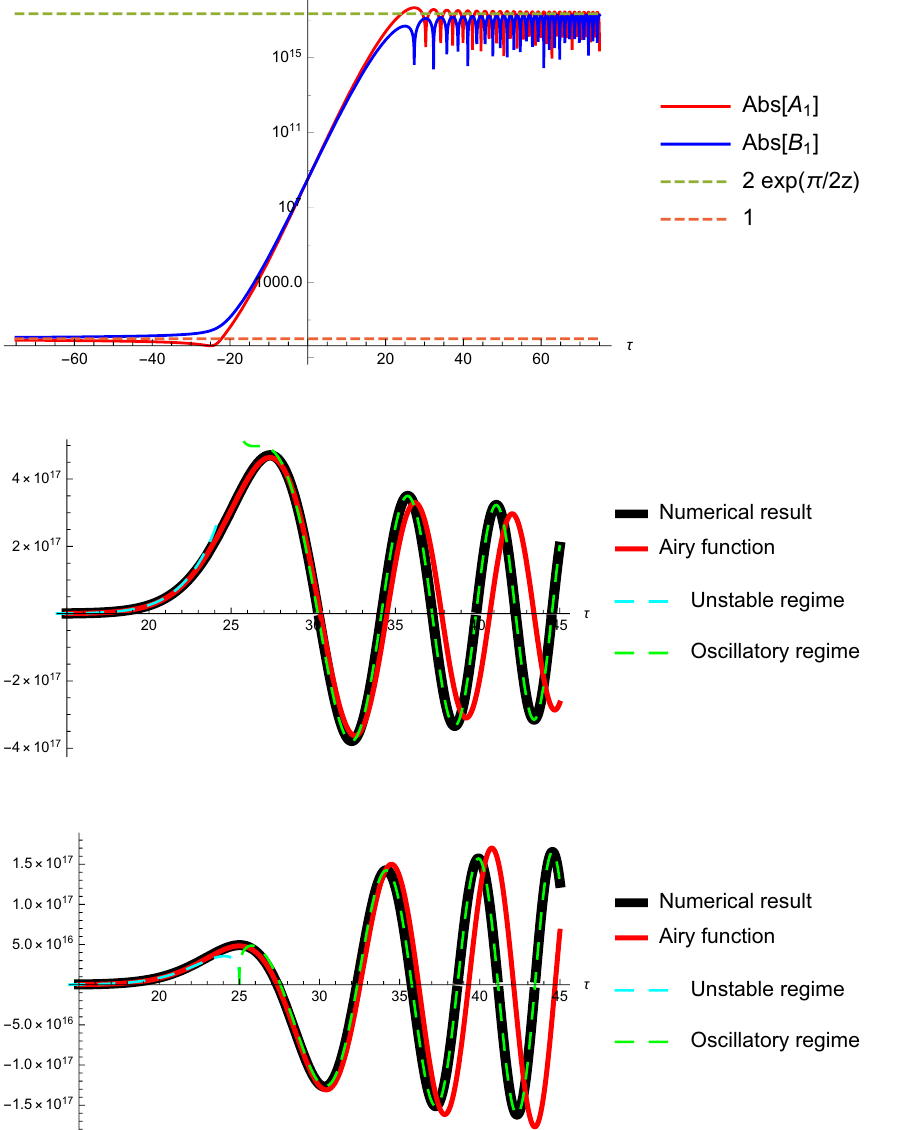
Figure 18 . Solution of eqs. (A.26), (A.27) with z = 0 : 04. The top panel shows j A 1 j and j B 1 j . The middle (bottom) panel shows comparison between numerical result of A 1 ( B 1 ) at (cid:28) ’ 1 =z = 25 with eq. (A.62), (A.63) (red lines), eq. (A.64), (A.65) (green dashed lines), and eq. (A.60), (A.61) (cyan dashed